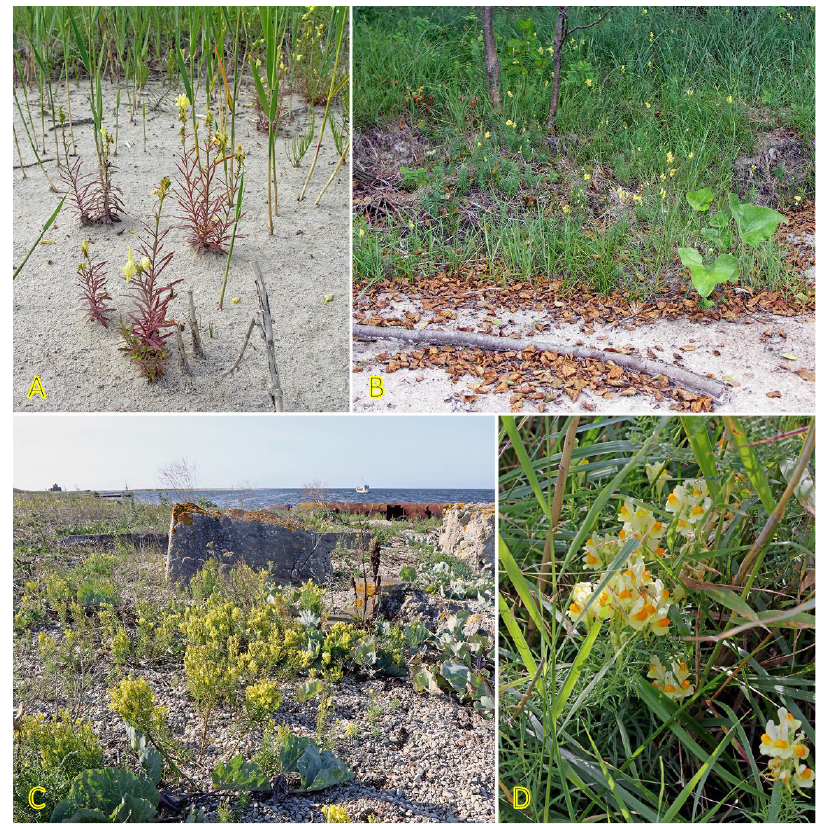
Figure 23. Linaria vulgaris plants on a sandy beach in Mērsrags, Latvia ( A ), on a forest edge near a wet sandy beach in Melnsils, Latvia ( B ), on a shingle beach on the island of Saaremaa, Estonia ( C ), on a wet coastal meadow on the island of Kihnu, Estonia ( D ).